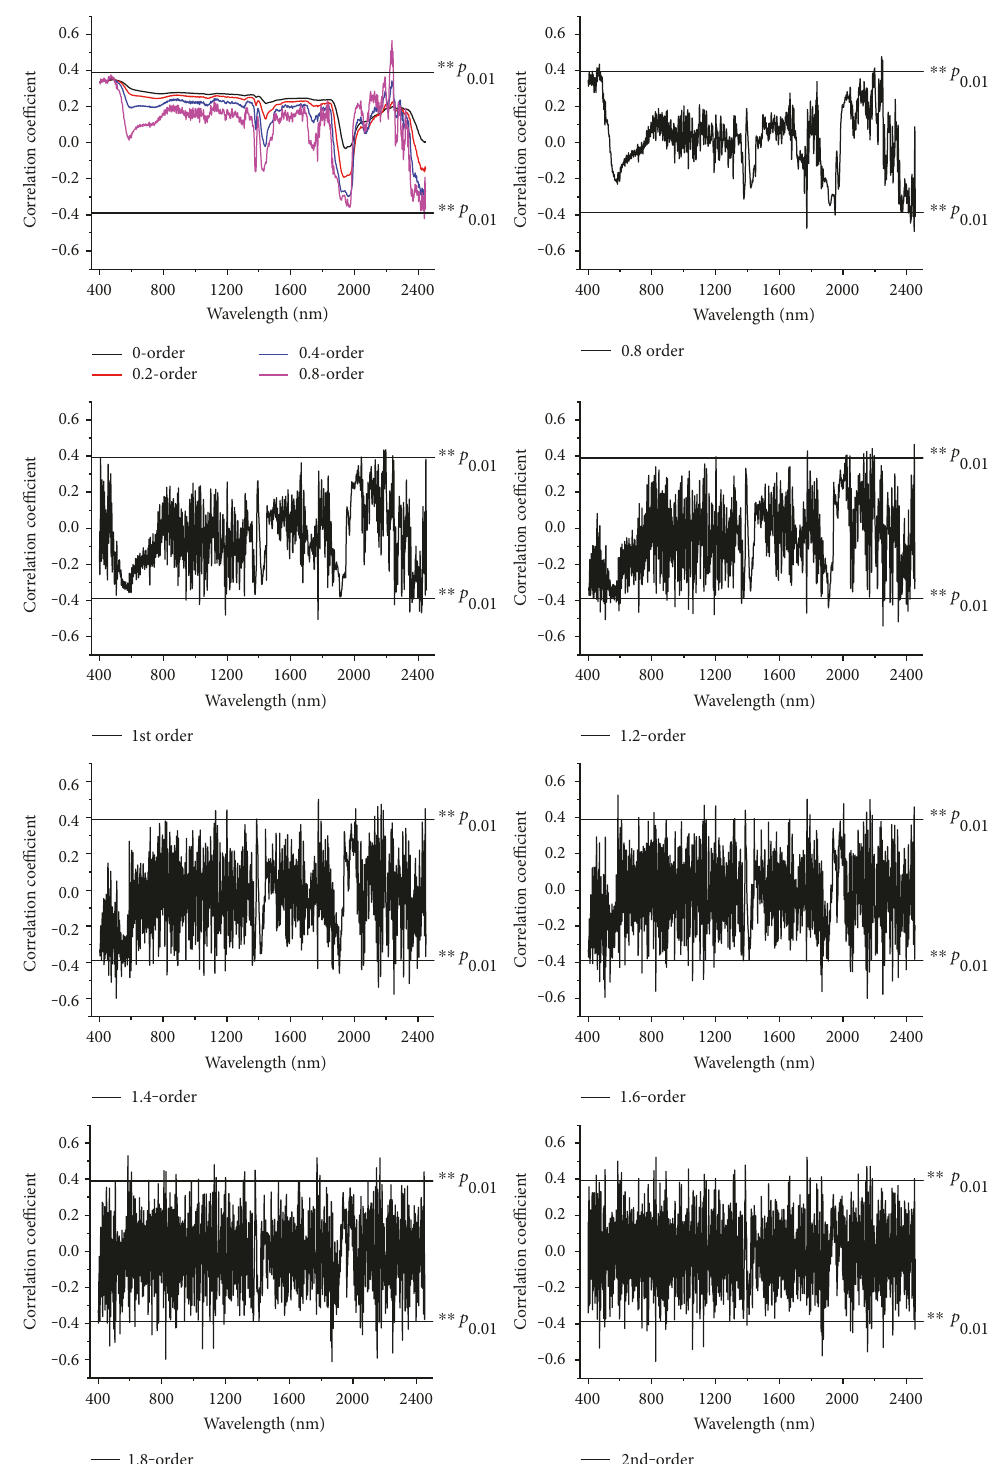
Figure 3: The correlation coe ffi cient between EC signi fi cance test of correlation coe ffi